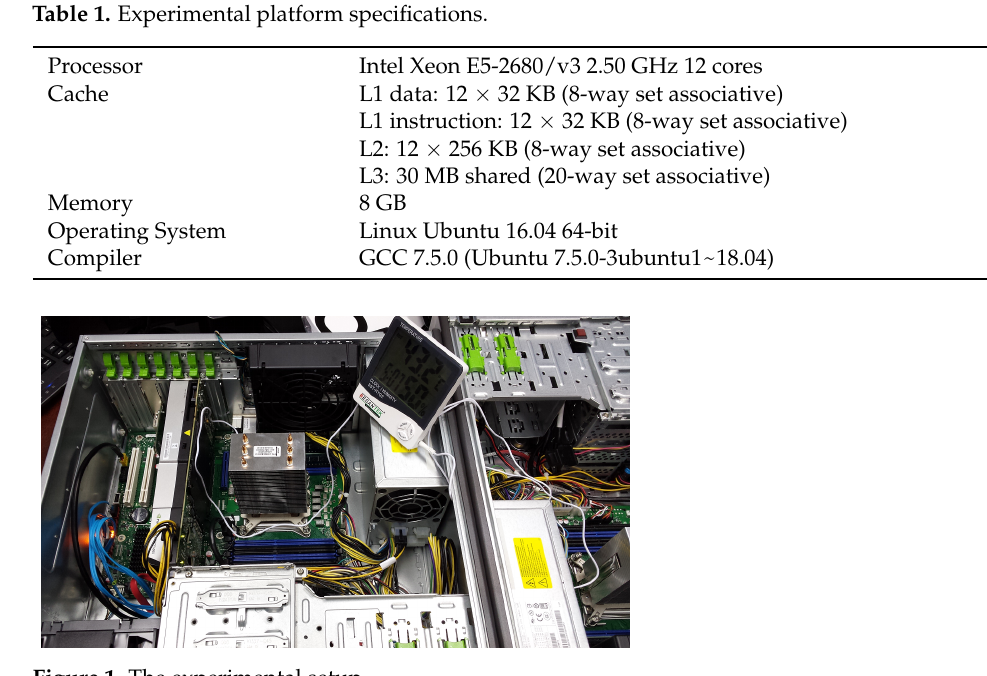
Figure 1. The experimental